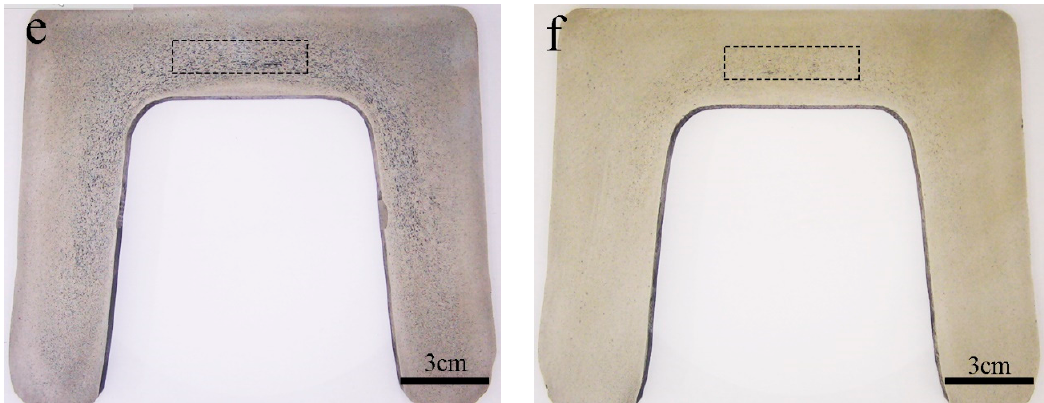
Figure 1. Macro-etching results of continuously cast billet and U-section steel. ( a , b ) Billets 1 and 2; ( c , d ) the enlarged image of the center region of Billets 1 and 2; ( e , f ) Steels 1 and 2. (Samples for microstructure observation and mechanical properties were cut from the central area of the black rectangle on the steel, shown in Figure 1 e , f ).